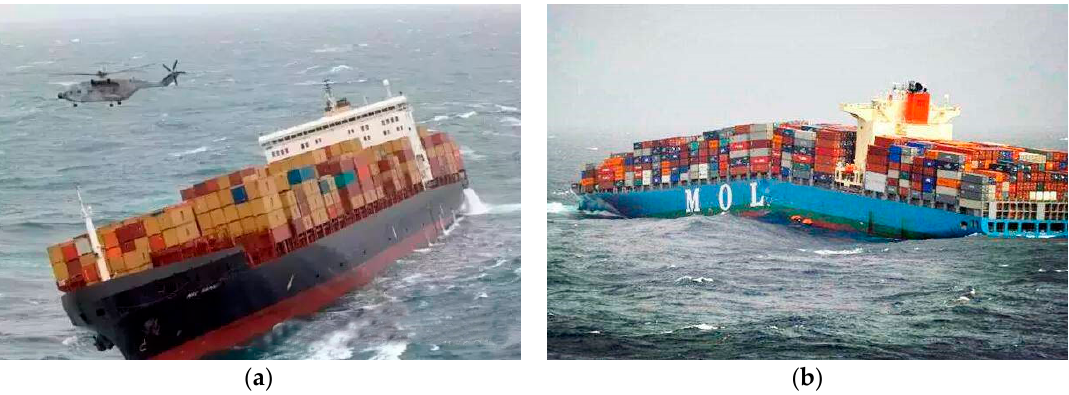
Figure 1. Structural failure of hull structures. ( a ) MSC NAPOLI; ( b ) MOL COMFORT.